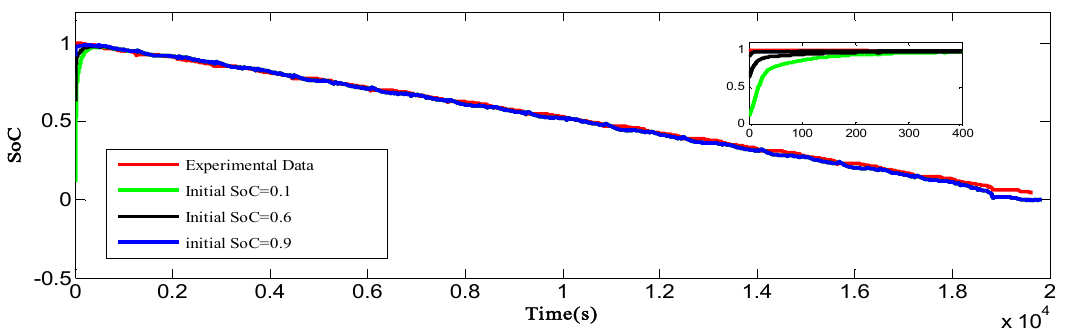
Figure 13. SoC estimation curves with different initial SoCs with UKF.